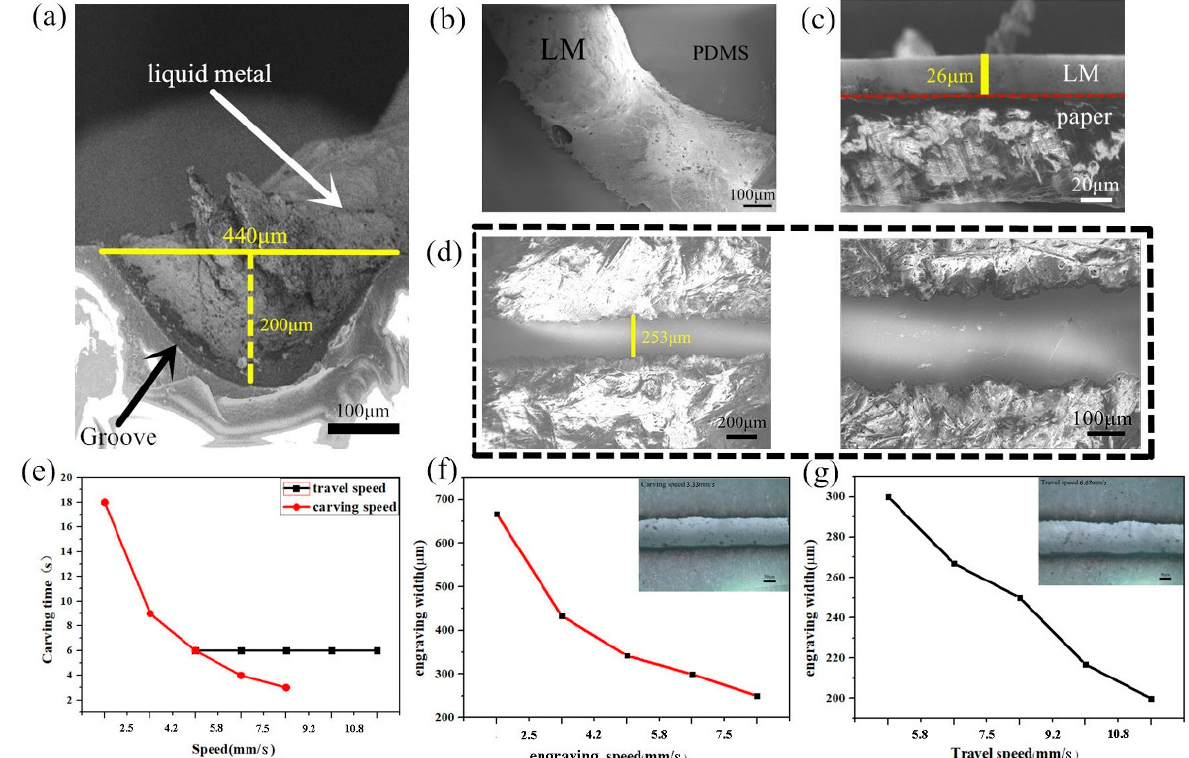
Figure 3. ( a ) Laser engraving of the groove pattern filled with LM on the PDMS substrate. ( b ) SEM image of the LM line filled on the PDMS substrate after laser engraving. ( c ) Cross-sectional SEM image of the LM line printed on the paper. ( d ) SEM image of the LM lines printed on the paper base at different magnifications. ( e ) Effect of carving speed and laser travel speed on the carving time. ( f ) Influence of the change in engraving speed on the width of engraving. ( g ) Influence of the change in travel speed on the width of engraving. In ( f , g ), the scalebar is 50 μ m.